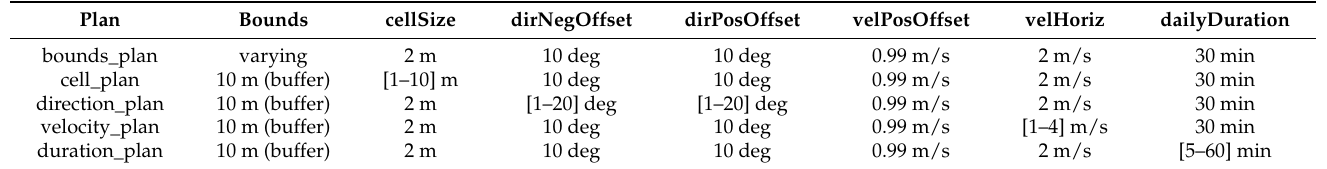
Table 4. The evaluation plans and the parameter